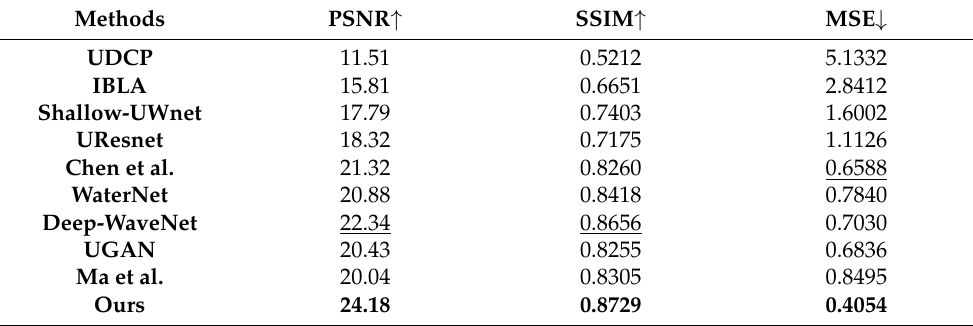
Figure 12. The visual comparisons of various UIE approaches on the Test-C60 dataset. Table 2. Quantitative comparison results of various UIE approaches on the Test-90 dataset in terms of PSNR (dB), SSIM, and MSE ( × 10 3 ). We present the optimal and sub-optimal results with values in bold and underlined, respectively.